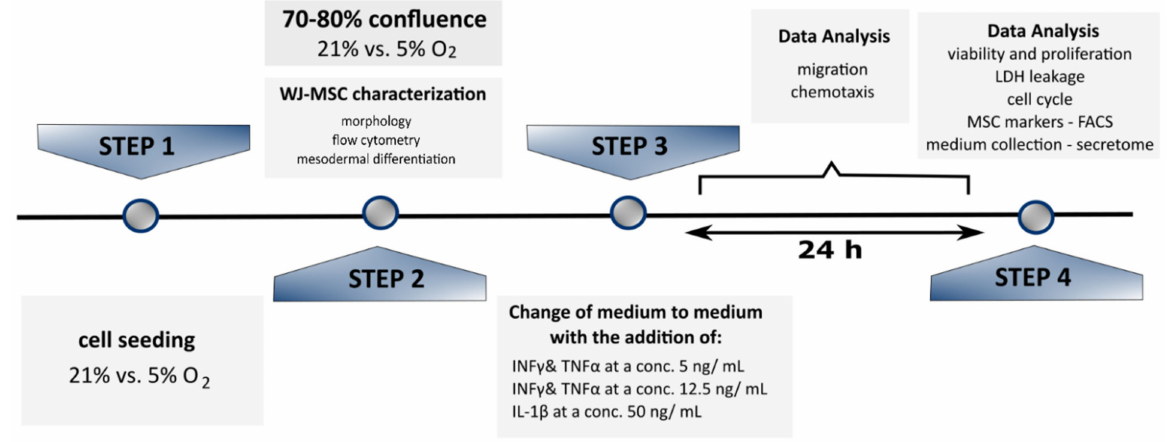
Figure 1. A schema of the experiments performed with selected cytokine